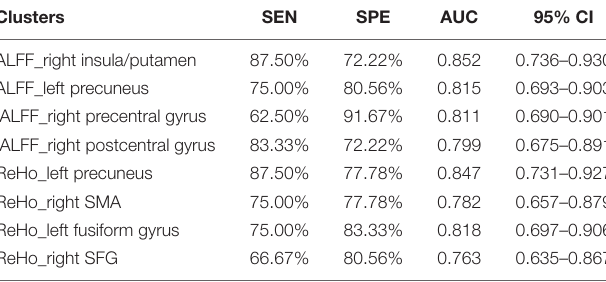
TABLE 5 | The statistics of ROC curve analysis for altered brain clusters that distinguish CSVD-c patients from controls.